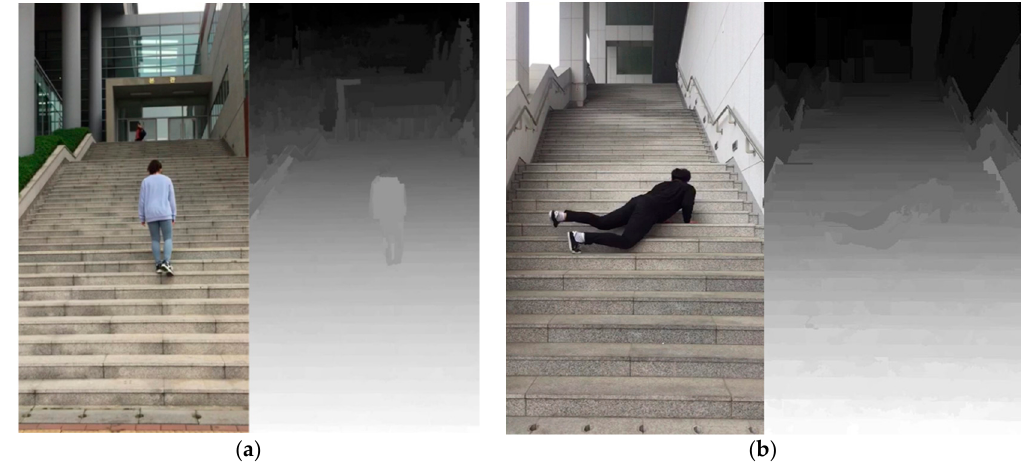
Figure 3. The extracted depth maps: ( a ) the person in the image is about 5 m away from the camera and ( b ) the person in the image is about 2 m away from the camera.